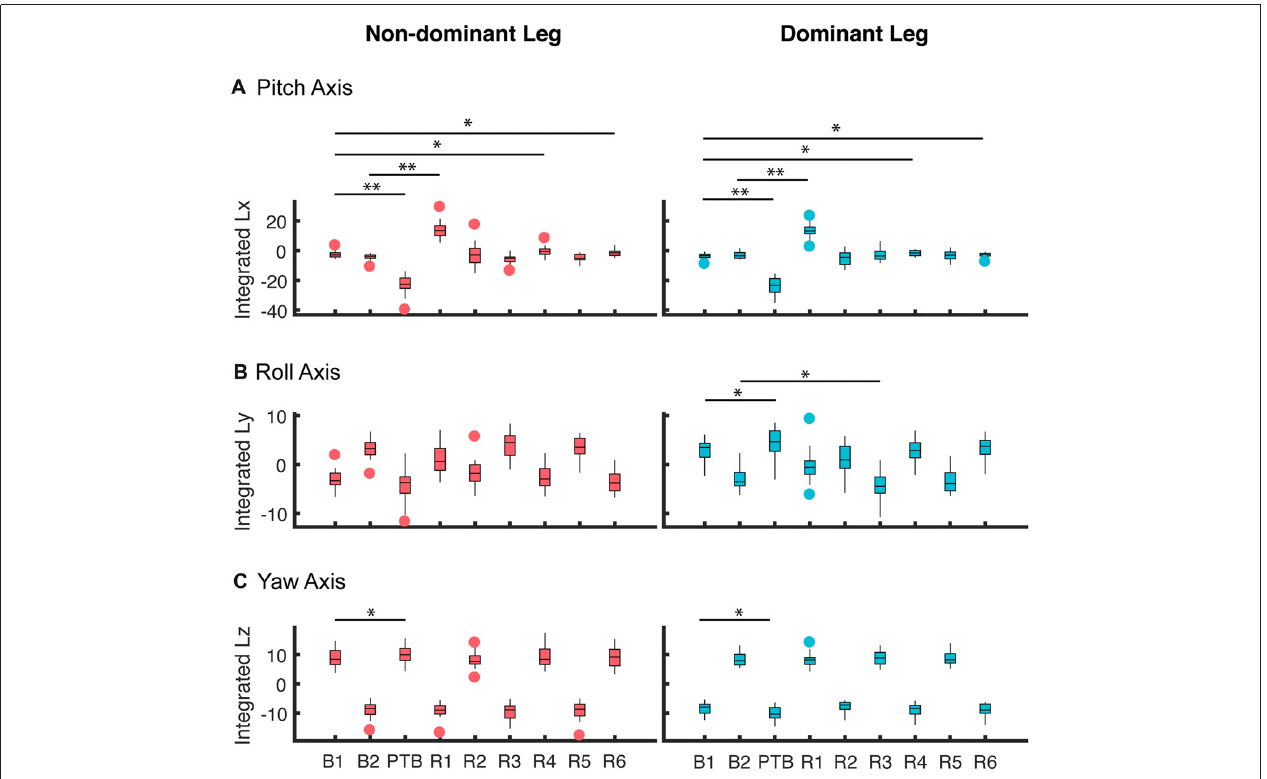
FIGURE 5 | Averaged integrated angular momentum over the step cycle for all participants about the (A) pitch, (B) roll and (C) yaw axes for perturbations that occurred on the non-dominant (left column) and dominant side (right column). These results represent the 0% asymmetry condition ( N = 19). The first step (B1) corresponds to the non-dominant limb for the left column and the dominant limb for the right column. Subsequent steps alternate between non-dominant and dominant. B: Baseline; PTB: Perturbation; R: Recovery. The horizontal bars and corresponding stars indicated whether the difference in integrated angular momentum between two steps was significant ( ∗∗ p < 0.001, ∗ p < 0.05). The data are represented as boxplots such that the lower and upper edges of the box indicate the 25th and 75th percentile of the data, respectively. The horizontal line within each box indicates the median. The whiskers extend to the furthest data point beyond the lower or upper edges of the box that is within a distance of 1.5 times the middle 50th percentile of the data. Points that lie beyond the whiskers denote